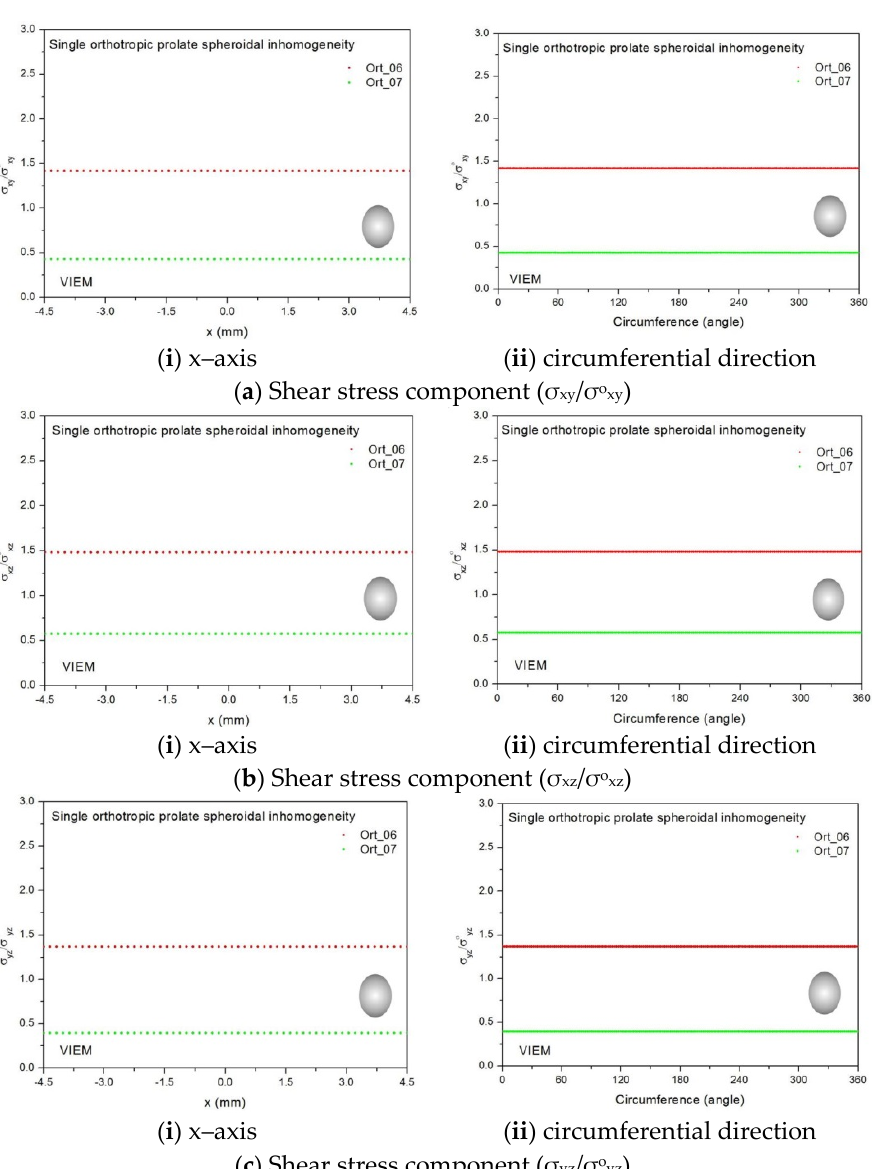
Figure 28. VIEM results for the normalized shear stress components ( a ) σ xy / σ oxy , ( b ) σ xz / σ oxz and ( c ) σ yz / σ oyz along ( i ) the x–axis inside and ( ii ) the circumferential direction of the orthotropic prolate spheroidal inclusions (Ort_06 and Ort_07) with a/b = c/b = 0.75 (b = 6 mm) under remote shear loading ( σ oxy , σ oxz and σ oyz ). Table 22. Normalized shear stress components ( σ xy / σ o xy , σ xz / σ o xz and σ yz / σ o yz ) within